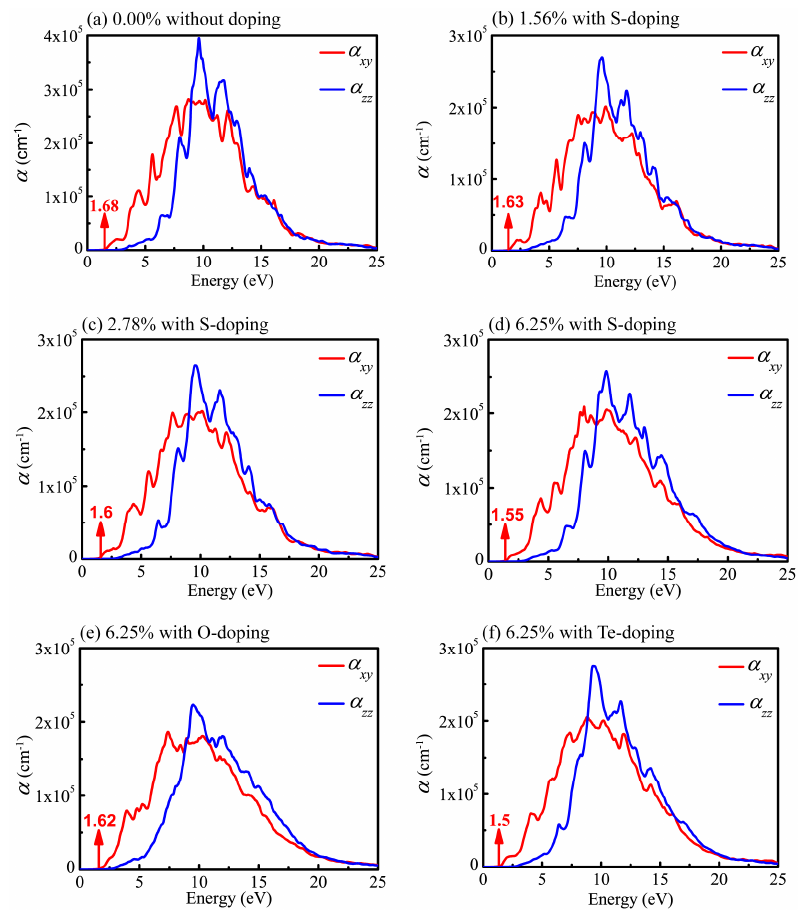
Figure 9. Absorption spectra of monolayer CSe in xy plane (red line) and along z axis (blue line). ( a ) pristine monolayer CSe; ( b – d ) S-doping at concentrations of 1.56%, 2.78% and 6.25%, respectively; ( e ) O-doping at 6.25%; ( f ) Te-doping at 6.25%.